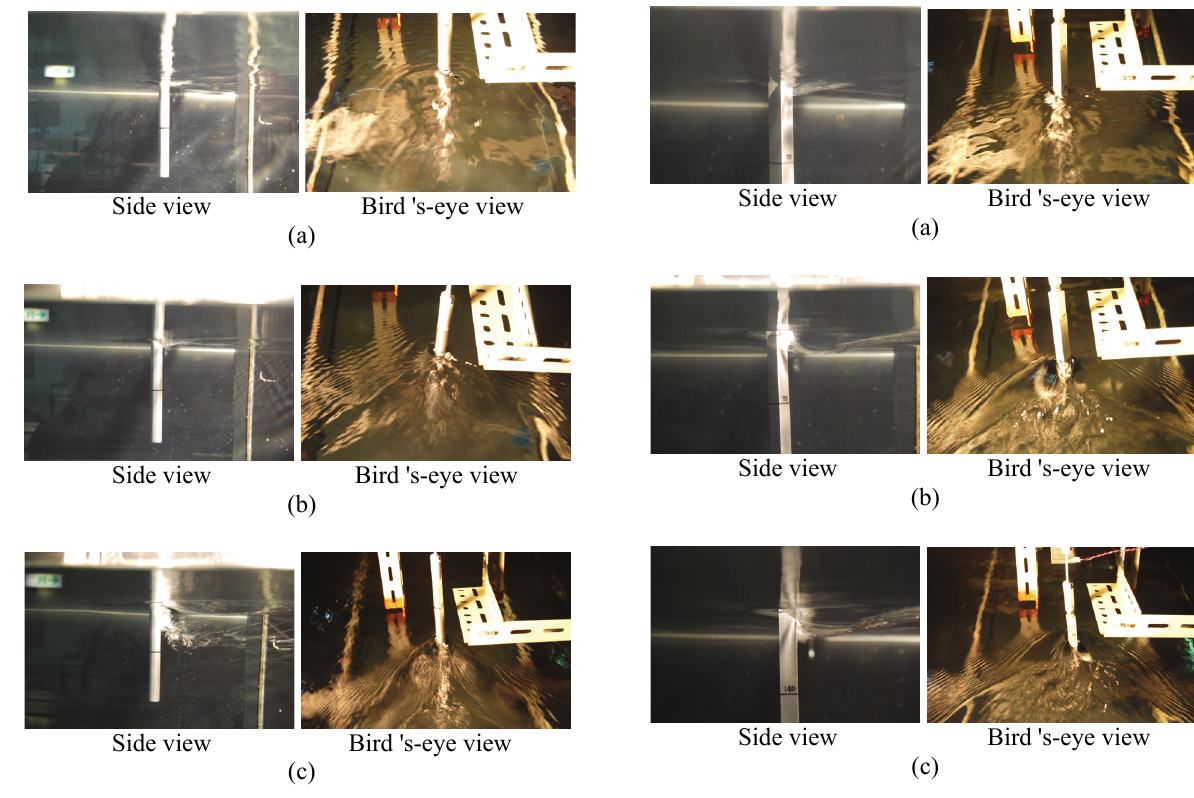
Fig. 7. Flow feature around circular cylinder, (a) flow velocity; 0.13 m/s, (b) flow velocity; 0.38 m/s, (c) flow velocity; 0.79 m/s